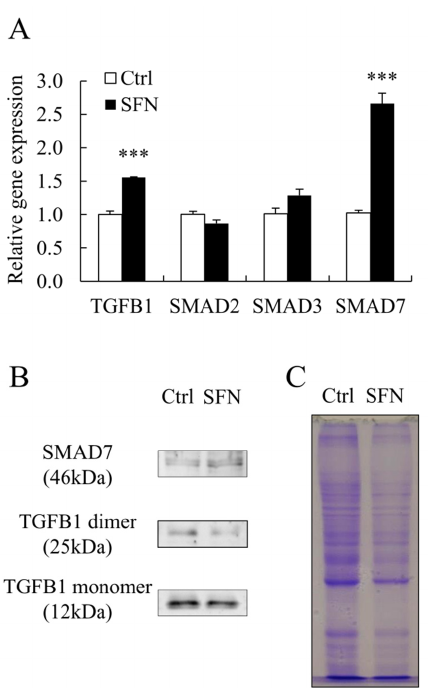
level of TGFB1 mRNA (Figure 4A,B), while decreasing the amount of TGFB1 protein (Fig- ure 4B). SFN treatment had no effect on SMAD2 or SMAD3 mRNA levels (Figure 4A).